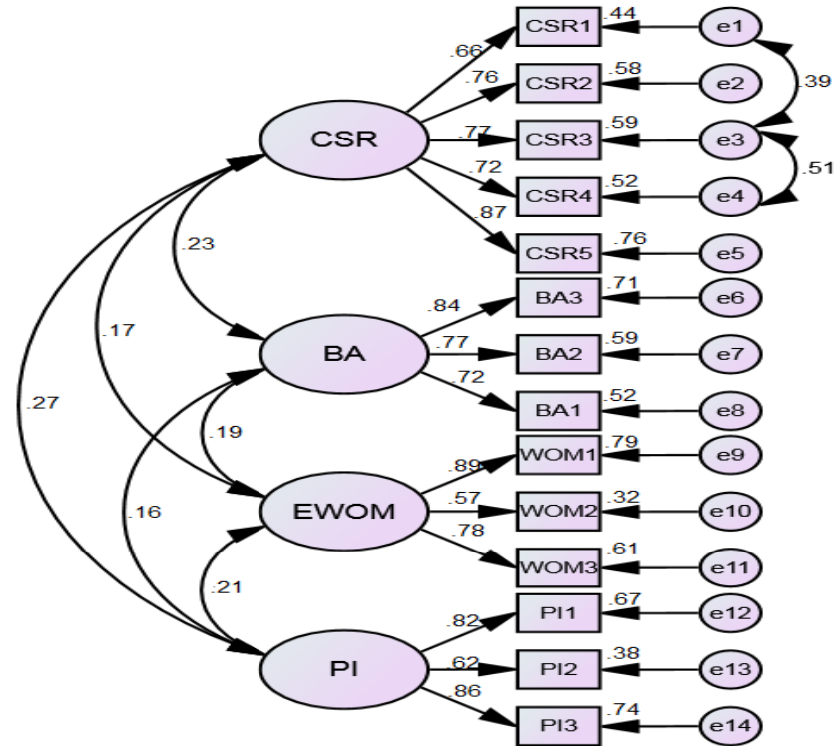
Figure 2. Results of confirmatory factor analysis for proposed theoretical model of the study.